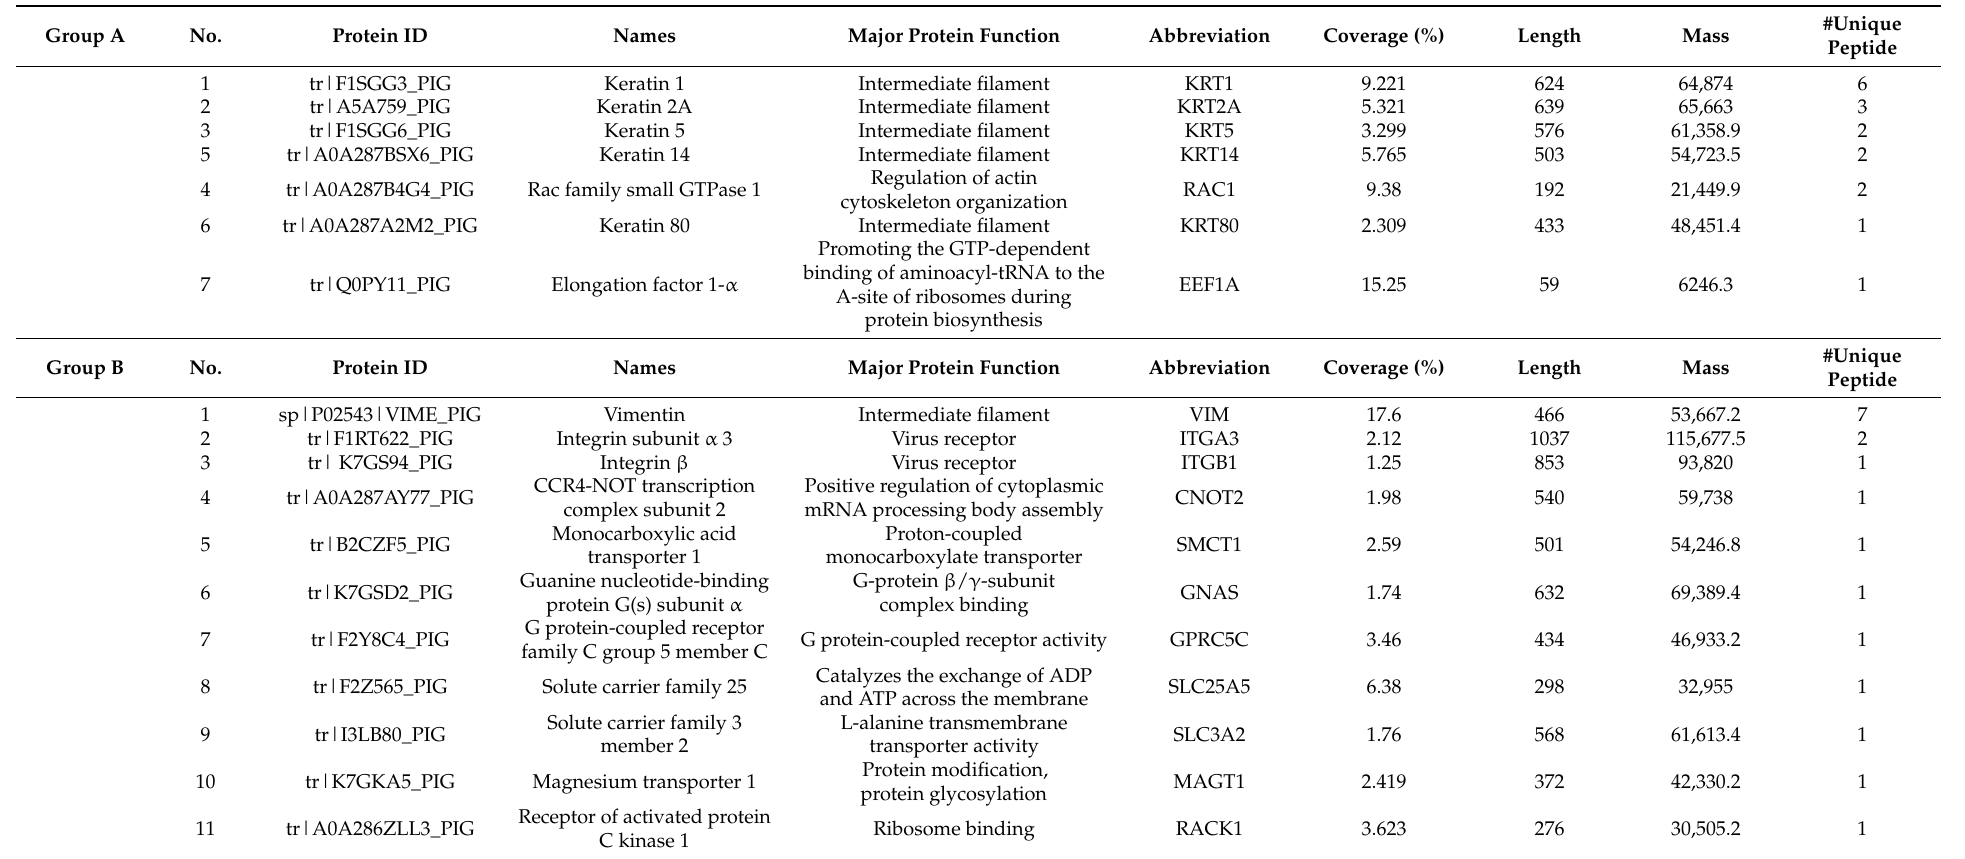
Abbreviations: Group A represents the proteins identified in the complexes of membrane proteins without PEDV infection after separation from the S1 antibody. Group B represents the proteins identified in the complexes of membrane proteins with PEDV infection after separation from the S1 antibody. The main functions of each protein are reported in the